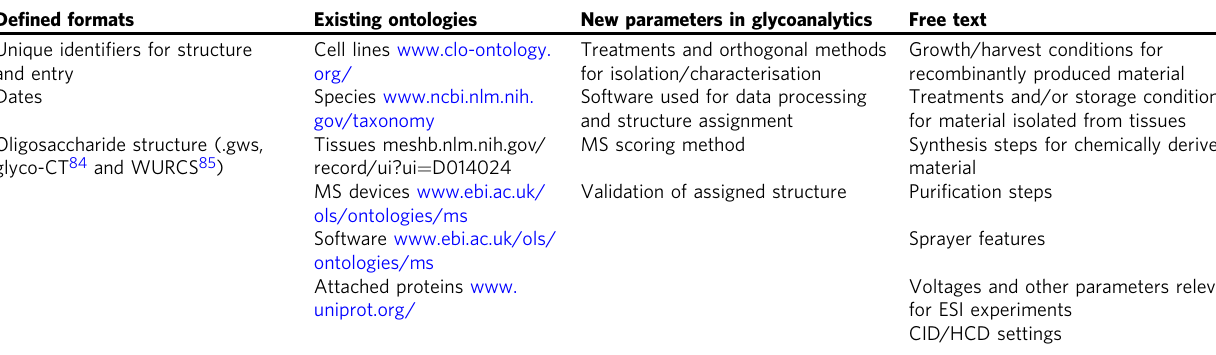
Table 1 Examples of parameters identi fi ed and included in the MIRAGE guidelines De fi ned formats